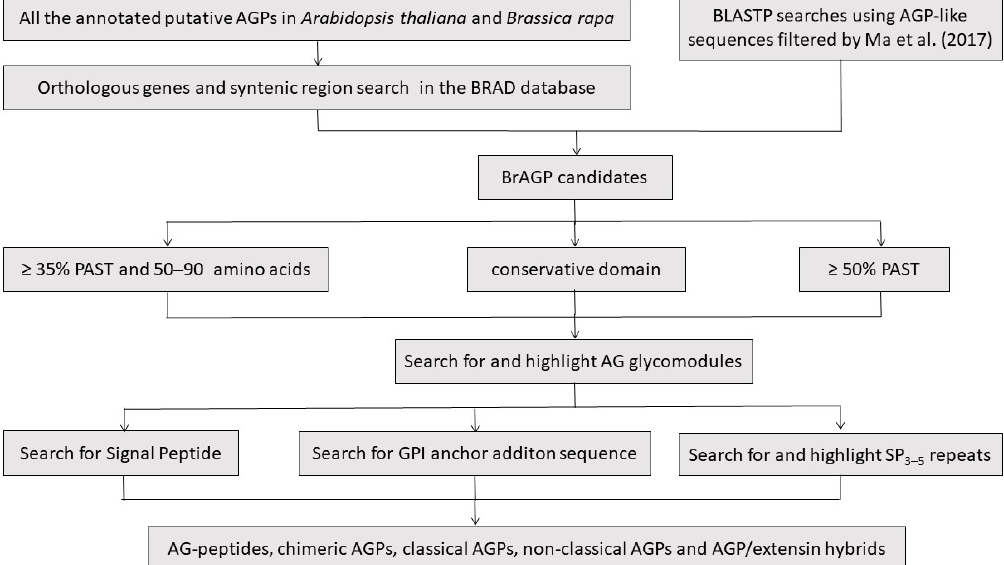
Figure 1. Schematic workflow of the integrated strategy in identification, classification and analysis of AGPs in Brassica rapa . Orthologous genes and syntenic searches of all the annotated putative AGPs in Arabidopsis thaliana and B. rapa were performed in the Brassica database (BRAD) to filter out AGP candidates. Additional BLASTP searches using AGP-like sequences were conducted in BRAD. Classical AGPs were defined as having greater than 50% PAST coupled with the presence of AG glycomodules and an N-terminal signal sequence. AG-peptides were defined to be between 50 and 90 amino acids in length with biased amino acid compositions of at least 35% PAST coupled with the presence of AG glycomodules and an N-terminal signal sequence. The presence of a GPI anchor addition sequence was used to provide added support for the identification of classical AGPs and AG-peptides. Chimeric AGPs were defined as possessing conservative domains coupled with the localized distribution of putative AG glycomodules. AGP/extensin hybrids were defined as containing two or more SP 3–5 repeats and a characteristic used to identify AGPs. The remaining AGP candidates with biased amino acid compositions of at least 50% PAST were deemed as non-classical AGPs.